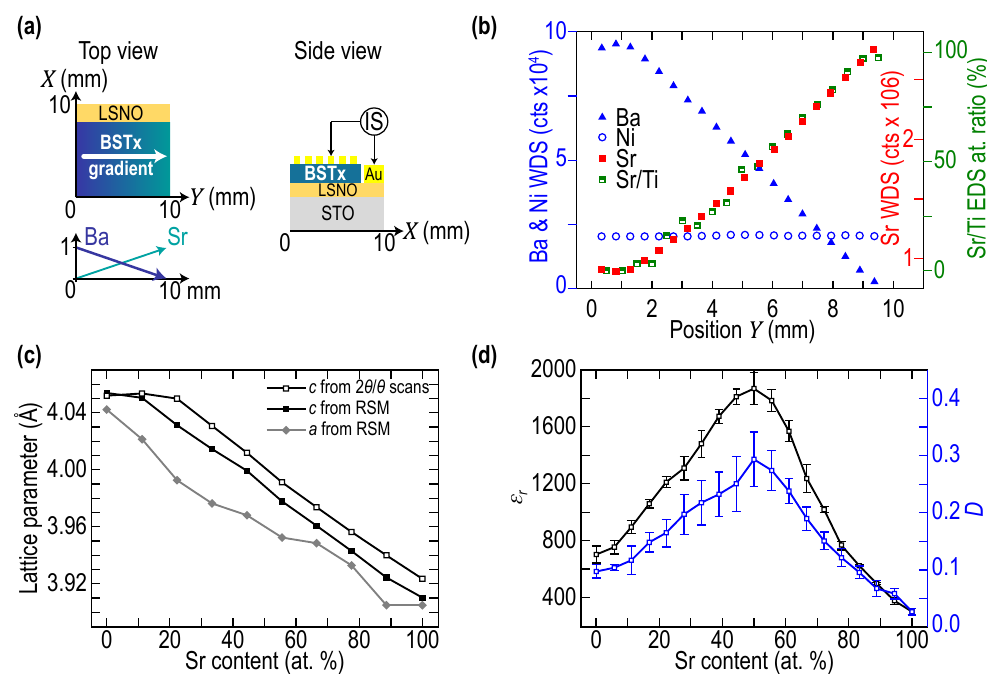
Figure 1. ( a ) Schematic of the BSTx laterally graded material library (top view) and of the heterostructure with top and bottom Au pads for impedance spectroscopy (side view). ( b ) EPMA WDS signal from Ba(L α ), Sr(L α ) and Ni(K α ) emissions as a function of position Y. Quantitative EDS Sr/Ti atomic ratio has been added for comparison (from Ref. [5] with permission). ( c ) In-plane and out-of-plane lattice-parameter dependence of BSTx on Sr concentration x and ( d ) dielectric permittivity ε r and losses D versus x. Figure 1c,d are adapted with permission from Ref. [5]. Copyright 2016